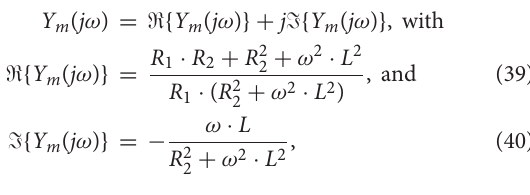
FIGURE 14 | Loci of the real (A) and imaginary (B) parts of the local admittance Y Q m = ( V m , I m ) = ( V m + R s · I m , I m ) = (2.9V,5.948mA) for R s = 330 (cid:127) , V m = 0.937V, and I m = 5.948mA (at the associated NDR operating point Q m = ( V m , I m ), the memristor state operating point X amounts to 478). (C) Locus of e e e evolves along the Nyquist plot as ω increases from voltage control, the threshold switching device is locally active and unstable at the NDR operating point Q m under focus, whereas the stabilizing resistance R s , meeting the constraint (13), turns the combined memristor into a locally-passive two-terminal circuit element at the associated operating point Q